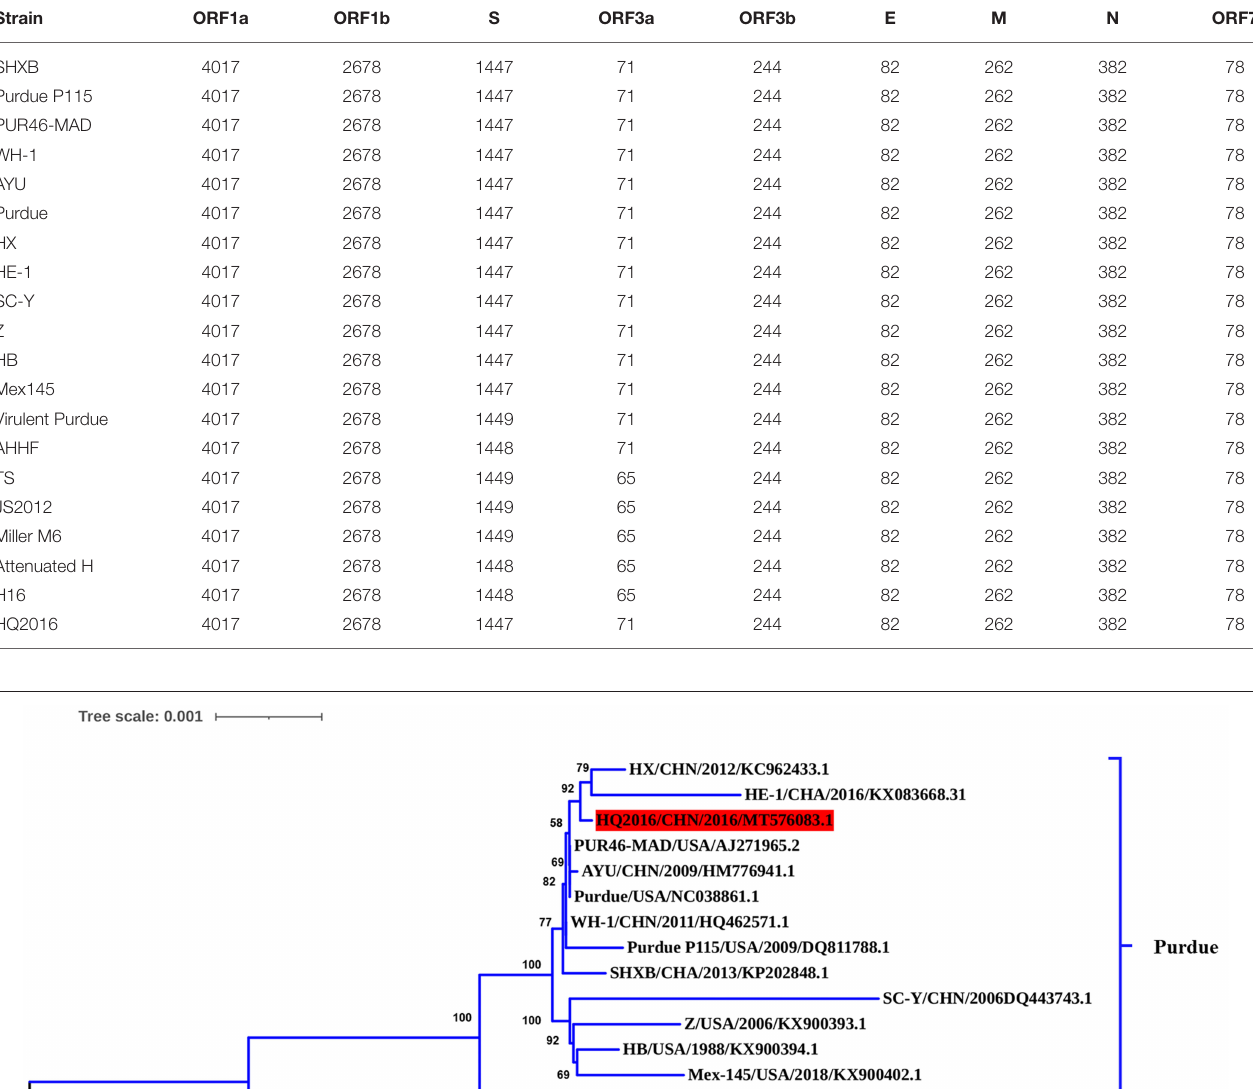
reproduced in these challenged piglets. At the end of the challenge experiment, samples of duodenum, jejunum, ileum, caecum, and colon were collected for viral RNA detection. At